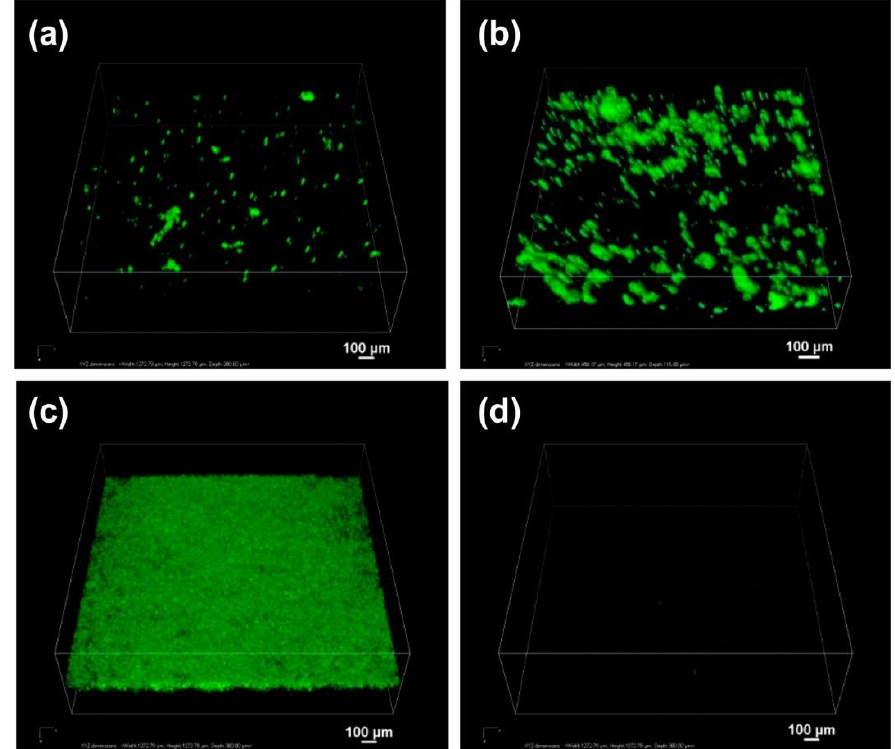
Figure 6. Confocal microscopy volume view images of porcine bladder wall incubated in artificial urine (pH 6.1) containing fluorescein isothiocyanate (FITC)-labelled-( a ) MSNPs-CD-OH, ( b ) MSNPs-CD-NH 2 , ( c ) MSNPs-CD-(NH 2 )-SH and ( d ) PBS (control) for 2 h. The green fluorescence indicates the presence of FITC-labelled MSNPs on the bladder wall. The data are representative images from three independent experiments. Scale bars are 100 µ m in all images. Reprinted with permission from Zhang et al. [101]. Copyright (2014) American Chemical Society.